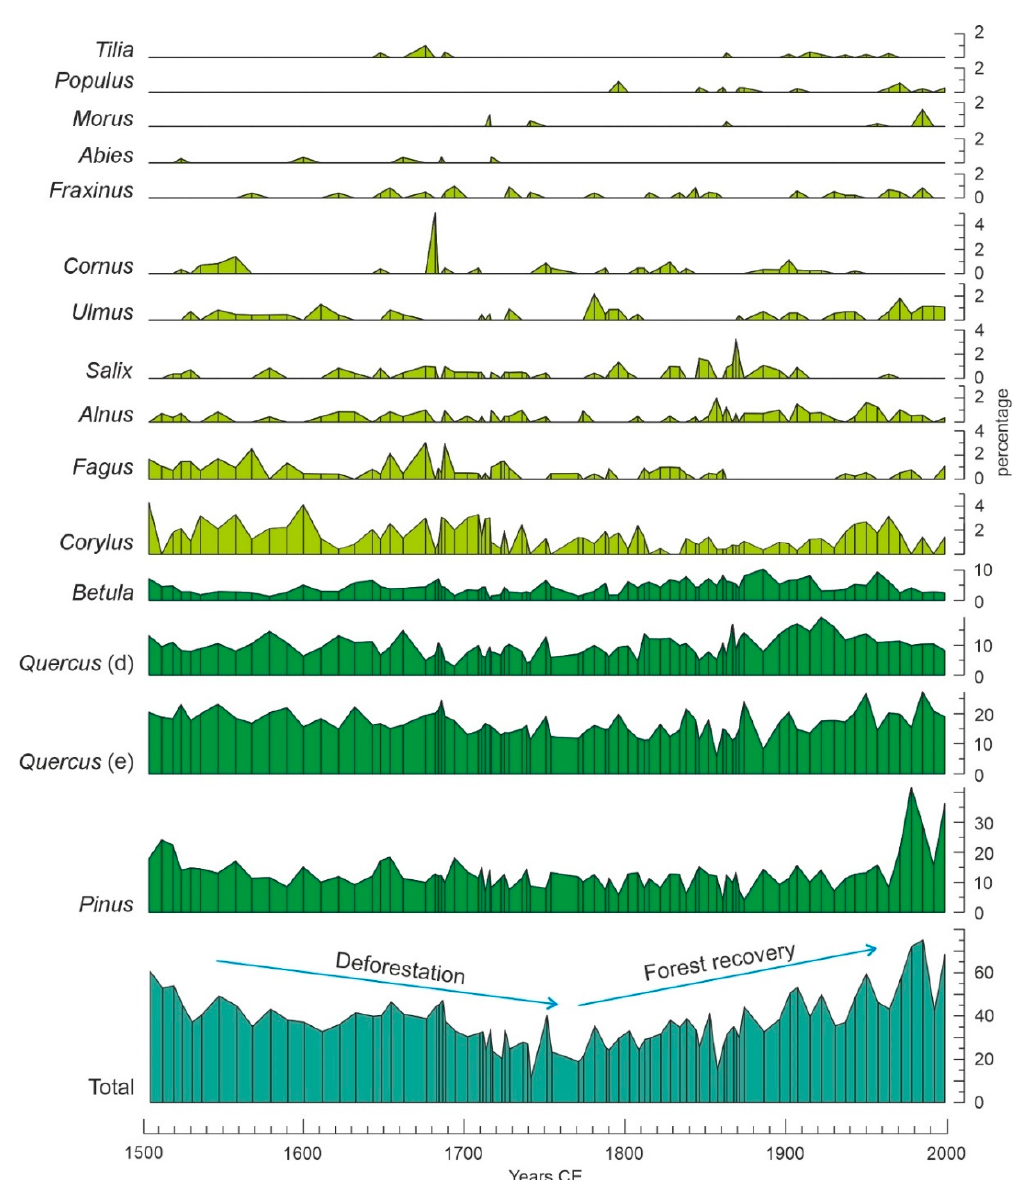
Figure 4. Pollen percentage diagram of forest tree taxa after recalculation excluding Cannabis from the pollen sum. A general deforestation trend culminating in the mid-18th century, followed by regional forest recovery, is clearly visible in the total curve [37]. Different green tones represent different scales to facilitate representation. Quercus (d), deciduous Quercus ; Quercus (e), evergreen Quercus .